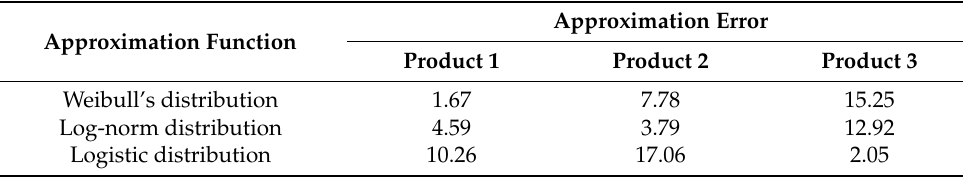
Table 3. Values of fitting errors for individual crushing products.